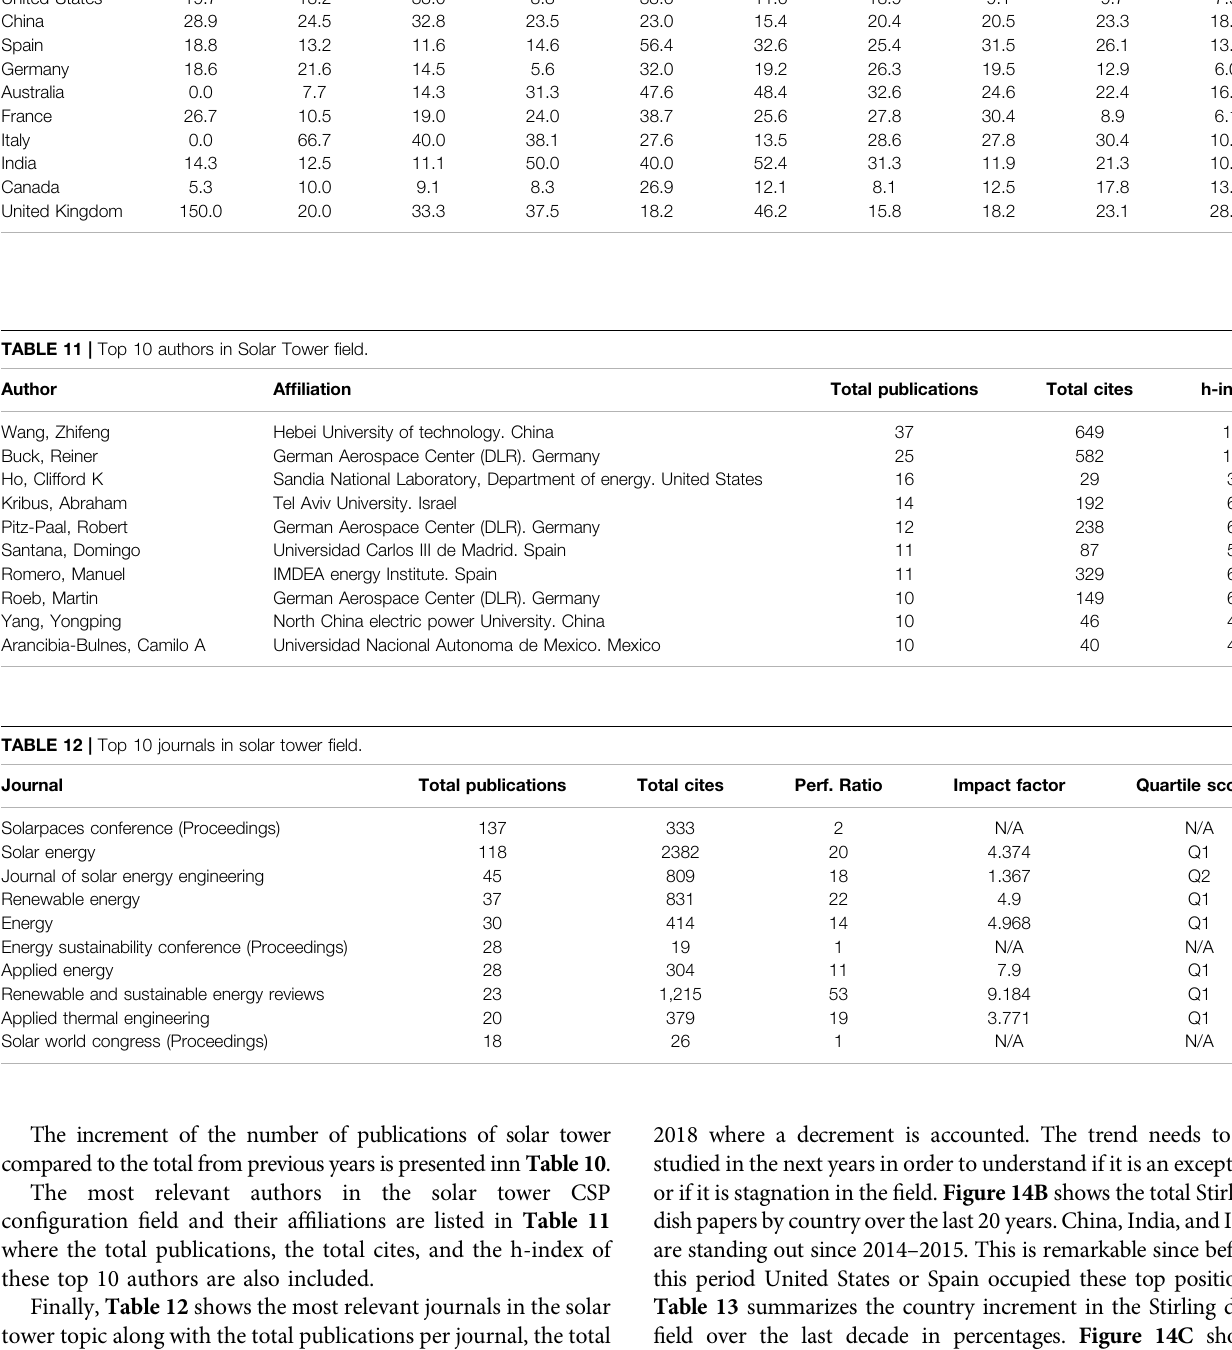
TABLE 10 | Country/region increment of solar tower publications compared to those accumulated from the previous year. Country United States